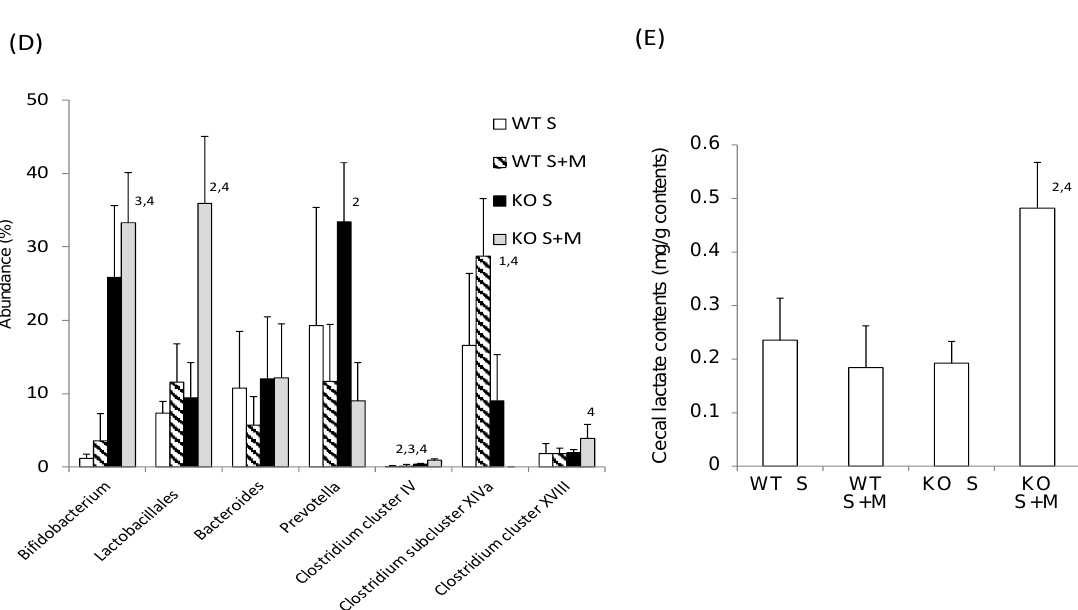
Figure 2. Sucrose plus miglitol diet-fed KO mice show cecal enlargement, higher lactate contents and altered intestinal flora. Eighteen week old male wild-type (WT) mice and ChREBP -knockout (KO) mice were fed a 30% sucrose (S) or 30% sucrose plus 0.08% miglitol (S + M)-containing diet for seven days. ( A ) Lengths (cm) of small intestine. ( B ) Representative image of intestinal enlargement. ( C ) Weight of cecal contents (% BW). Open arrows indcate cecum. Cecum in KO S and KO S + M were enlarged. ( D ) Gut microbes in cecum contents of WT and KO mice are expressed as a percentage of total DNA sequences. ( E ) Cecal lactate contents (mg/g). Data represented as mean ± SD (n = 6 per group). 1 WT S vs. WT S + M, p < 0.05, 2 KO S vs. KO S + M, p < 0.05, 3 WT S vs. KO S, p < 0.05, and 4 WT S + M